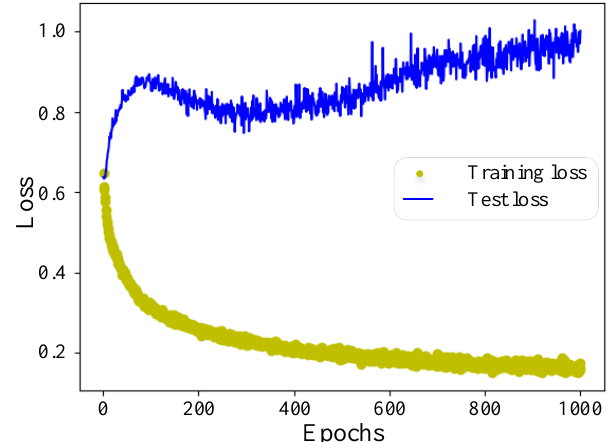
Figure 6. FLS model loss using a one-step training strategy.